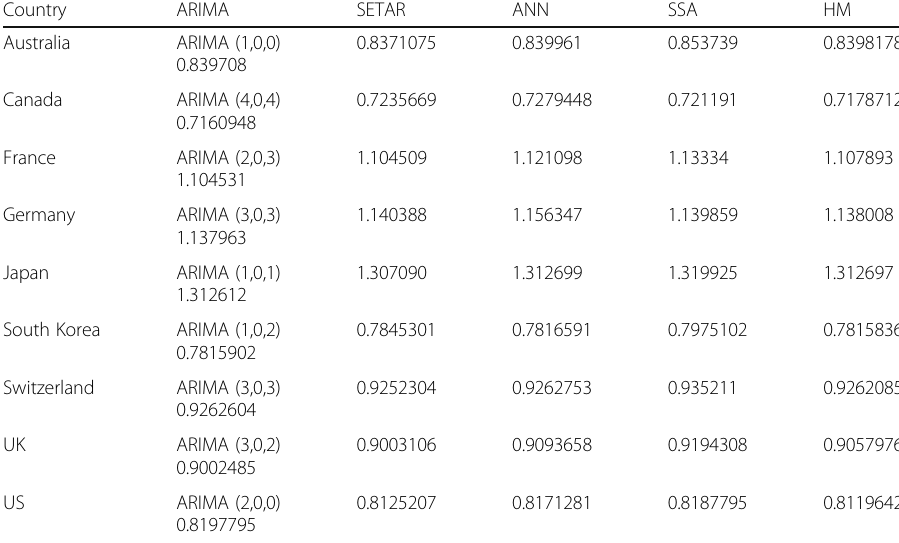
Table 4 RMSE Values of the Forecasting Models for Developed Markets